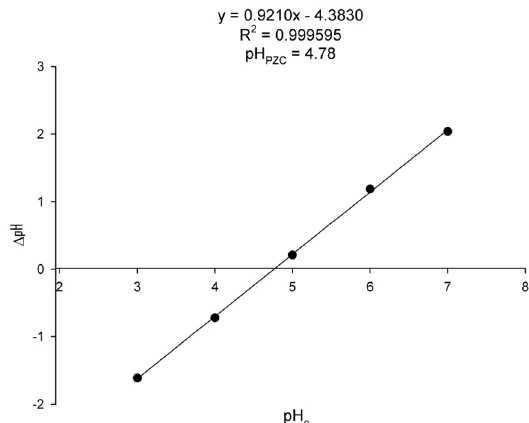
Figure 1. Point of zero charge (PZC) of HA bovine